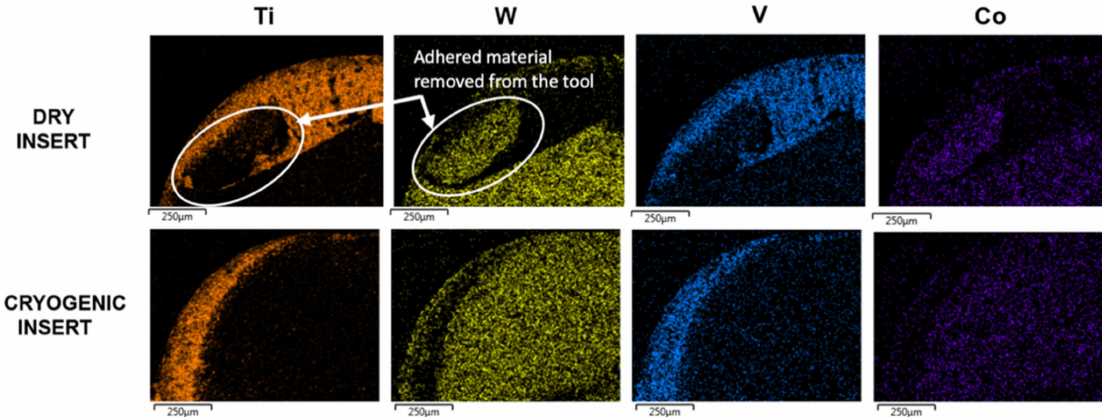
Figure 17. EDS element maps for dry and cryogenic